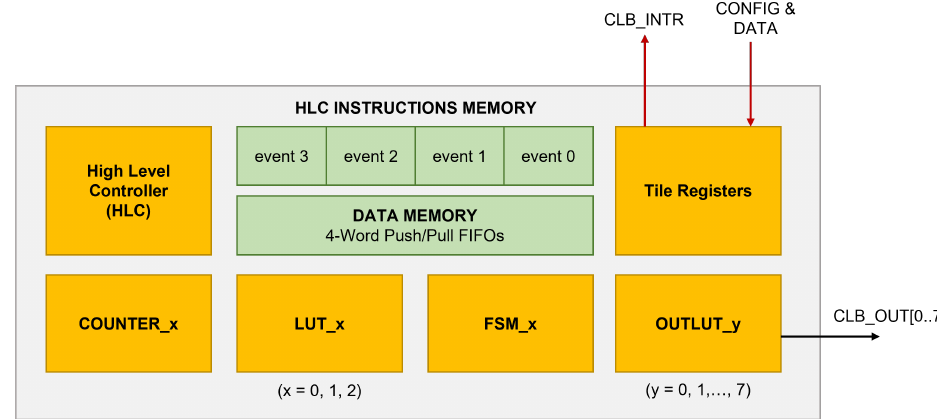
Figure 4. CLB tile structure.